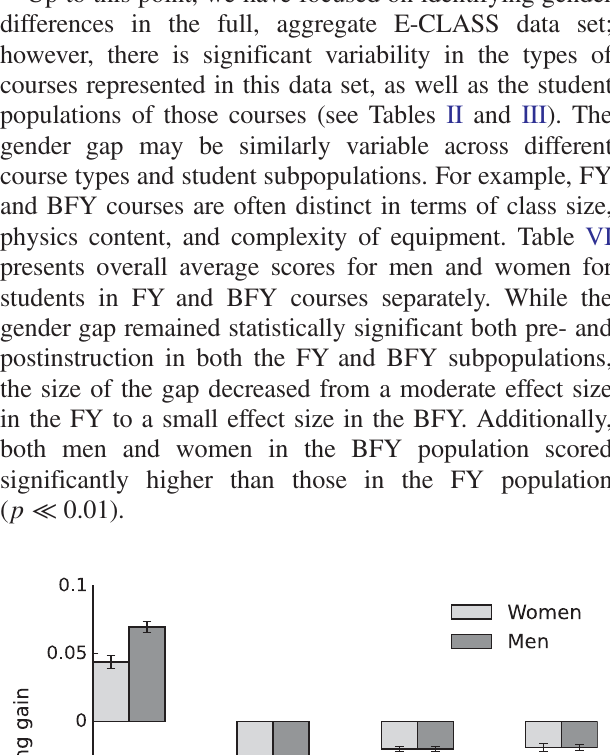
TABLE V. Formula for the four metrics for learning gain used here. In some cases the formula has been generalized to account for the fact that the minimum E-CLASS score is − 30 points rather than 0